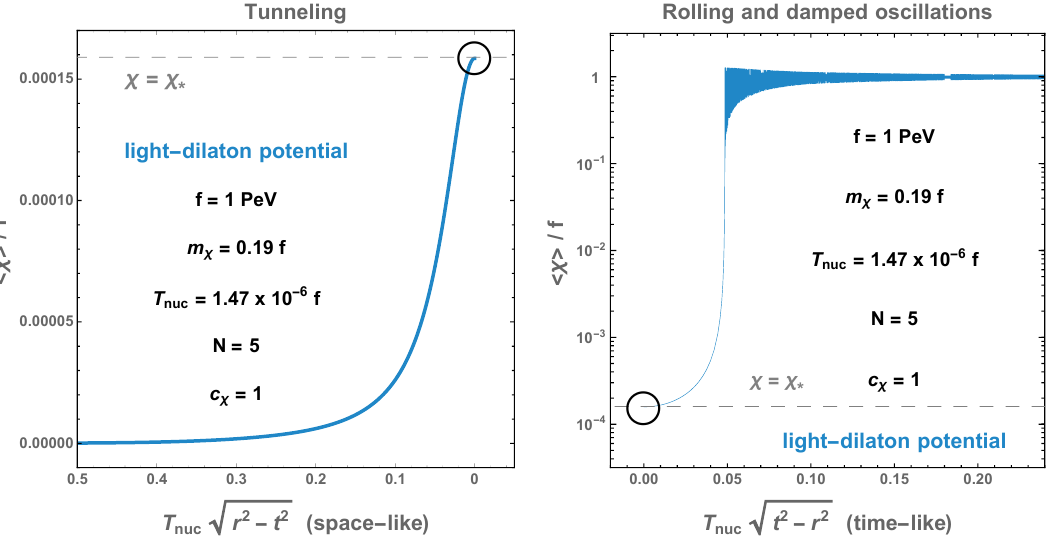
Figure 11 . Left: bounce profile at nucleation. It interpolates between the false vacuum h χ i = 0 outside the bubble and the release point h χ i at the center of the bubble. Right: evolution of the ∗ scalar field after tunneling. First, the scalar field rolls along the shallow part of the nearly-conformal potential and then realized oscillations with period ∼ f − 1 with a damping time . T − 1 (cid:29) f − 1 . nuc Taking into account the decay of the scalar field would reduce the damping time after the first oscillation. The full bubble wall profile can be obtained after connecting the two figures through the two black